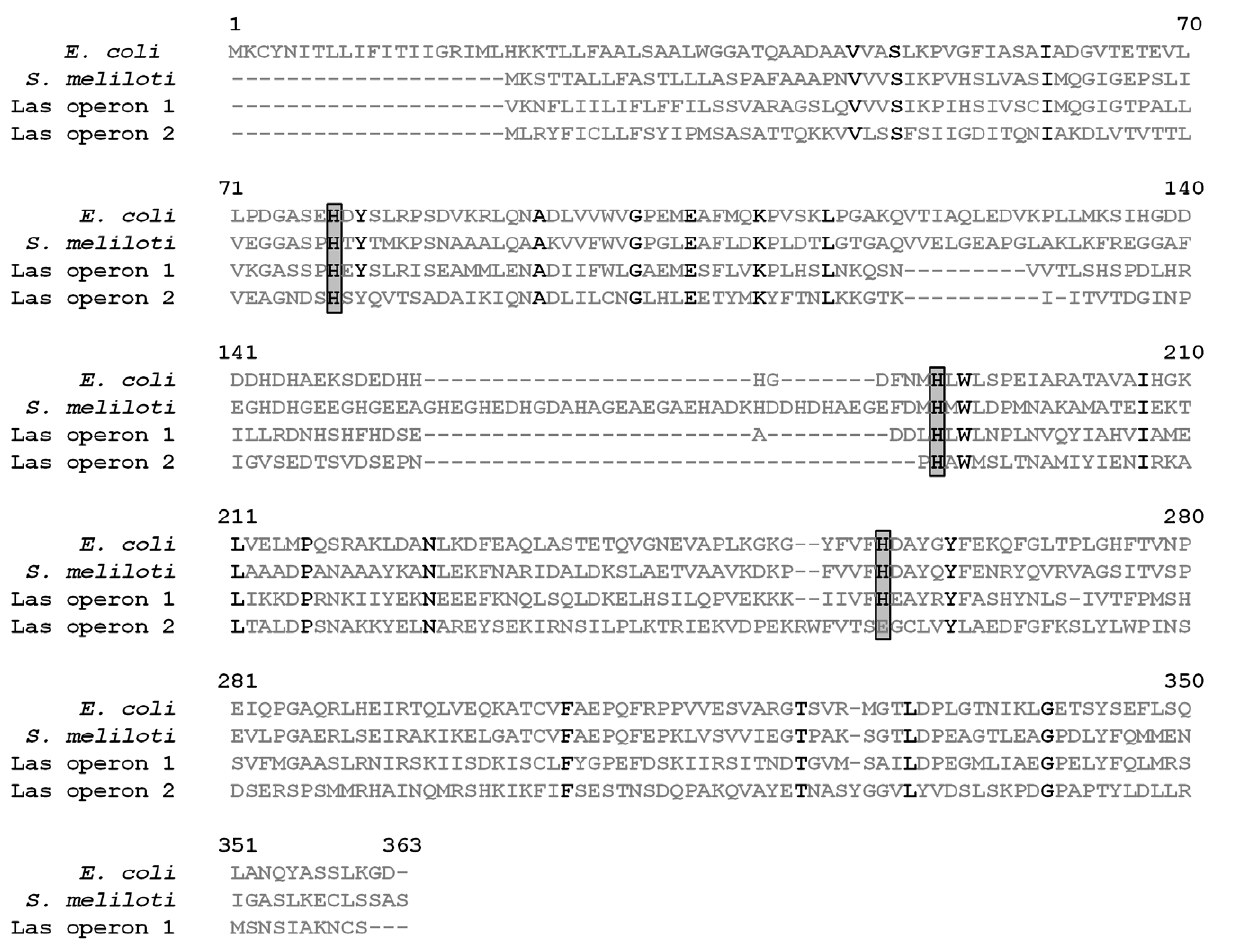
Figure 7. Sequence alignment of ZnuA orthologues. Orthologues to ZnuA from S.meliloti and Ca. Liberibacter asiaticus were aligned to ZnuA from E.coli using ClustalW. Residues that are 100% conserved amongst all orthologues are shown in bold. The three conserved His residues involved in binding zinc are shaded gray.